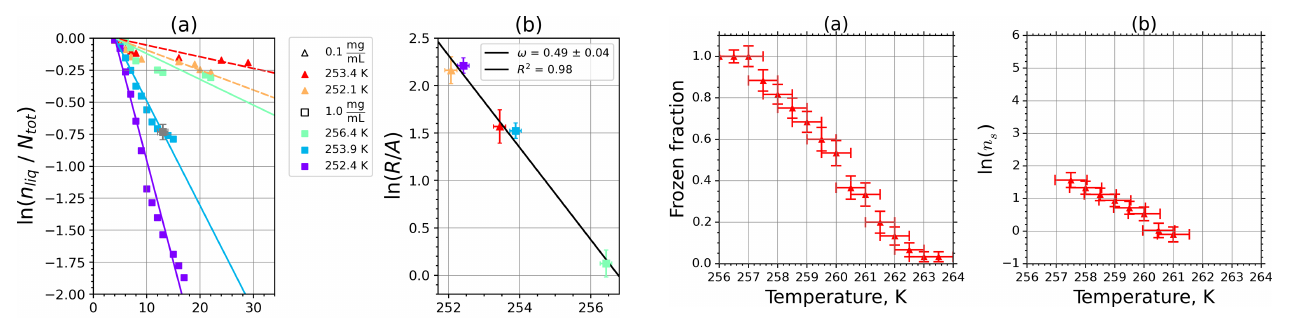
Figure 6. Kaolinite: (a) the decrease in fraction of droplets which remained liquid with time at different temperatures in the isother- mal experiments in the M-WT. The colors correspond to different temperatures; experiments with particle concentrations of 0.1 and 1gL − 1 are plotted by triangles and rectangles, respectively. The gray symbol marks a data point for 1gL − 1 at 253.9K and indi- cates typical error bars. (b) Freezing rate of kaolinite normalized to surface area as a function of temperature calculated from (a) using Eq. (21). The horizontal error bars are the 1 σ values of the measured temperatures, while the vertical error bars represent the fit error in R/A calculation.